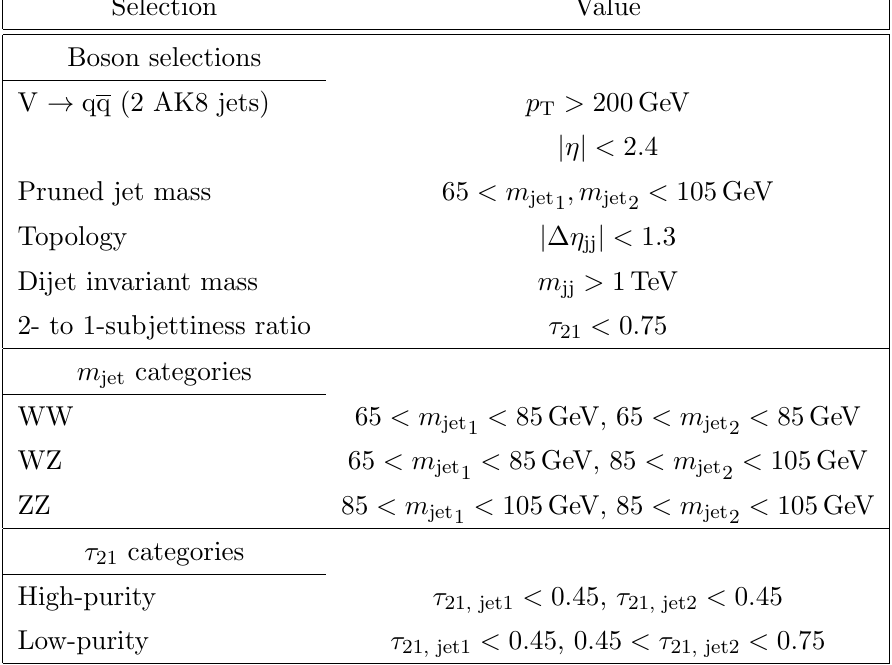
Table 4 . Summary of the (cid:12)nal selections and categories for the dijet